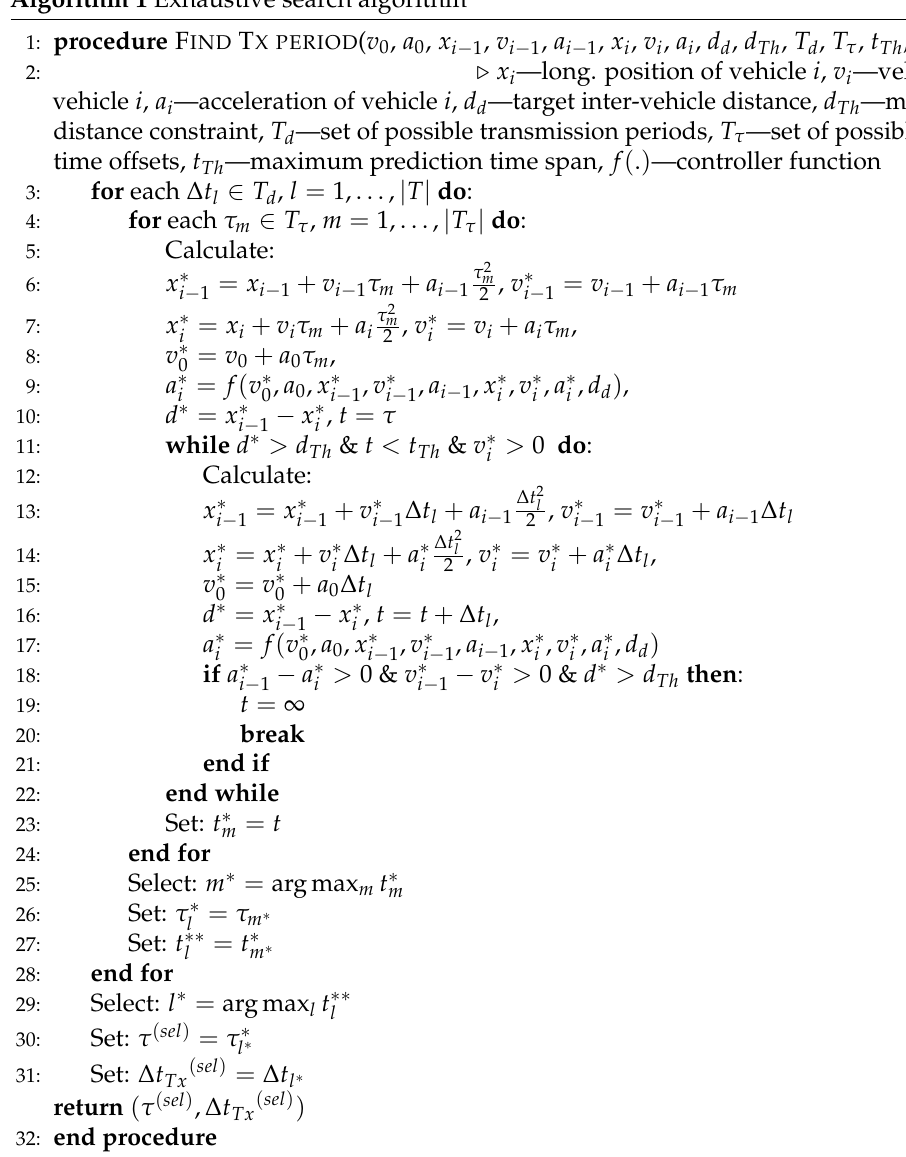
Algorithm 1 Exhaustive search